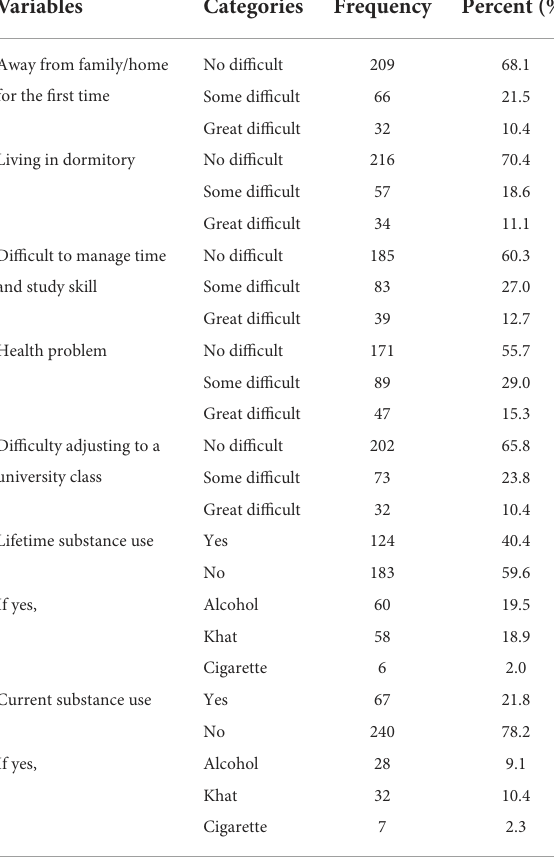
TABLE 2 Social, academic, and substance-related factors of Wollo University main campus first-year regular undergraduates, Northeast, Ethiopia, Dessie, 2020 (n =